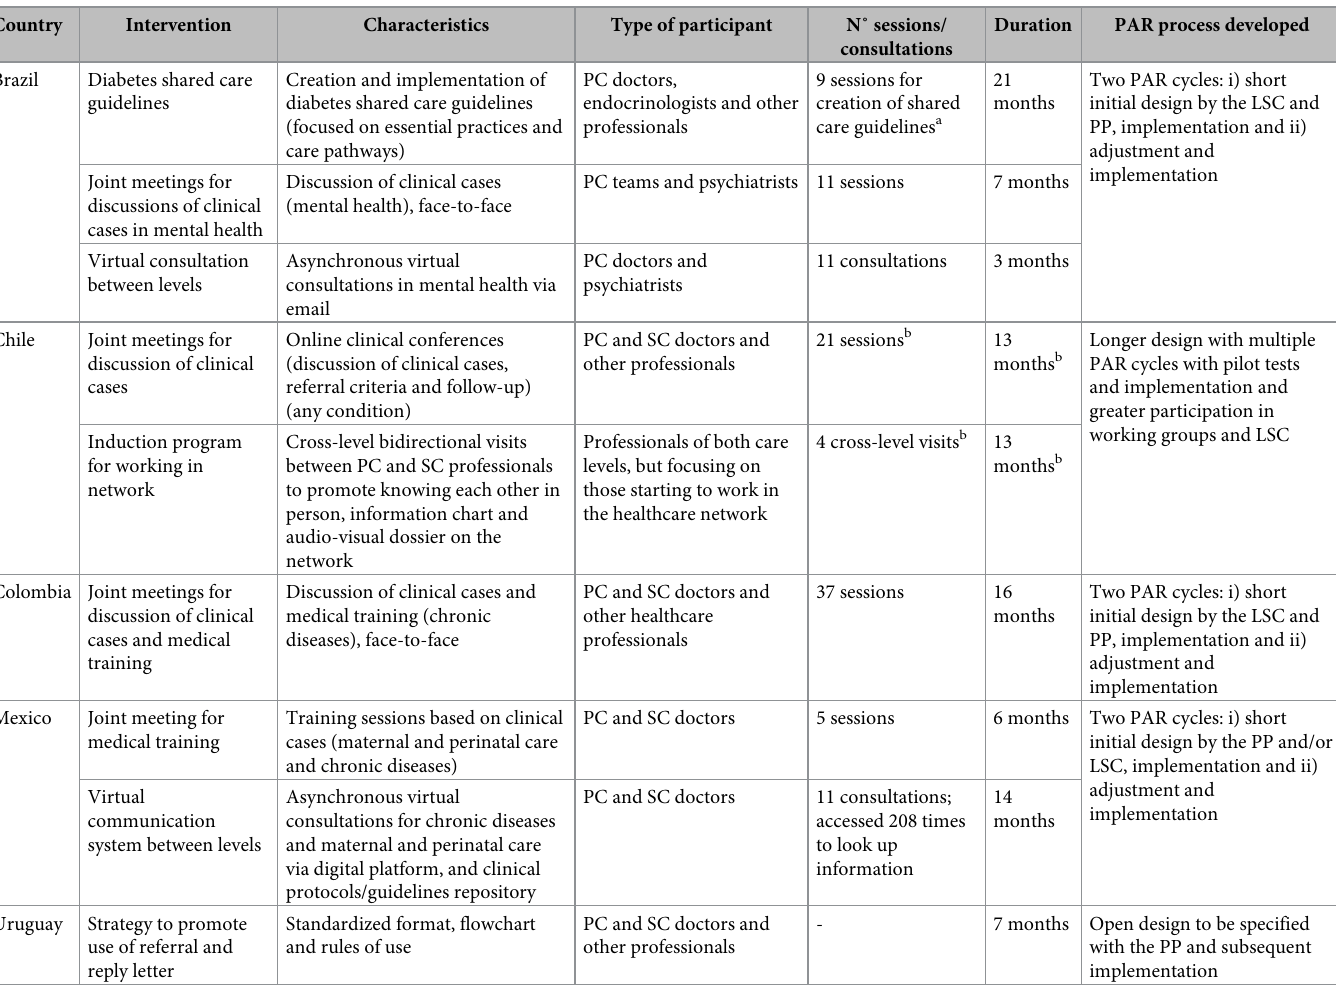
Table 1. Characteristics of the interventions and type of PAR process developed for the selection, design and implementation of the